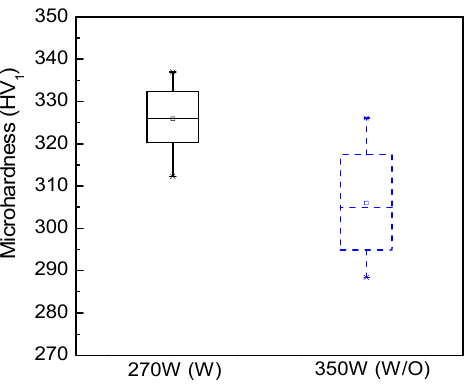
Figure 9. Microhardness of the top surface of deposited block with/without ultrasonic vibration (powder: Inconel 718; scanning speed: 8.47 mm/s; powder feed rate: 2.5 rpm).